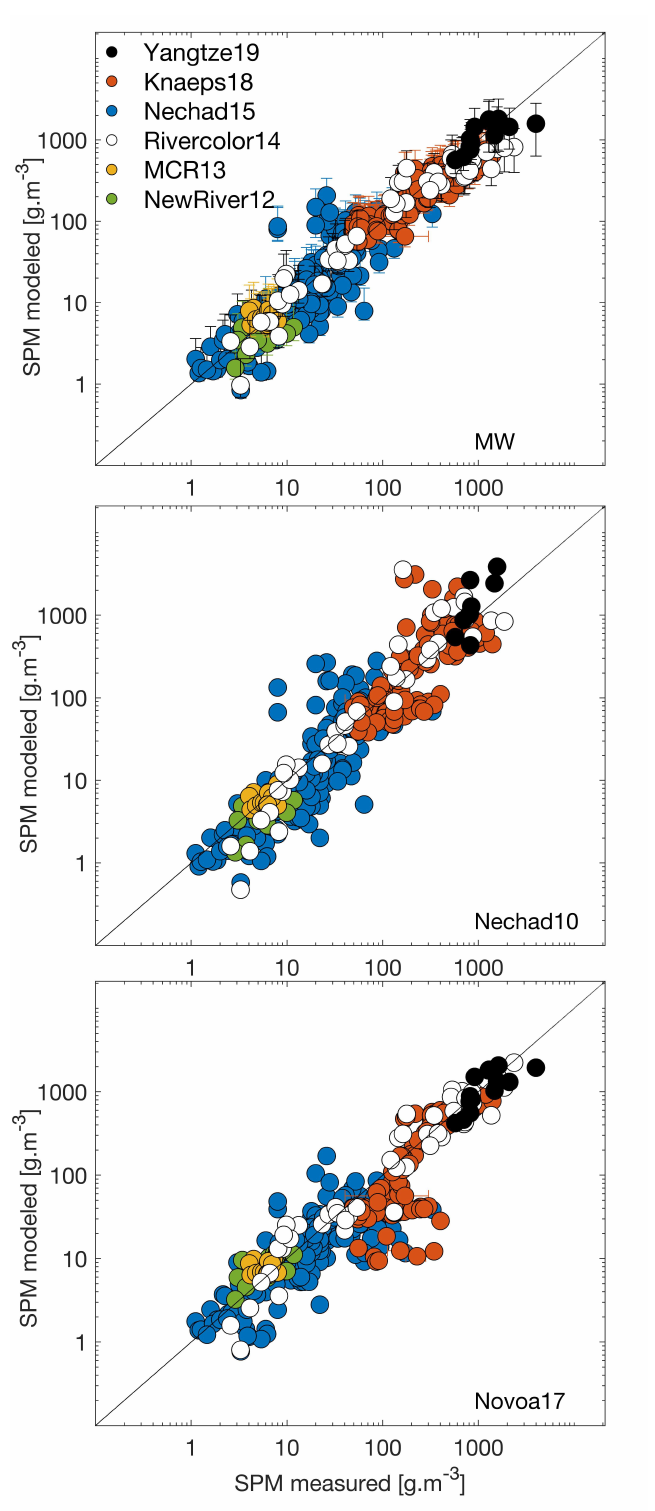
Figure 3. Modeled vs. measured Suspended Particulate Matter—SPM values for this study (multi-wavelength semi-analytical algorithm—MW algorithm), Nechad10, and Novoa17. Vertical error bars are the uncertainties obtained with the MW algorithm (see Section 2.2.4). Horizontal error bars are uncertainties in measured SPM, when made available by data sources. Solid line is the 1:1